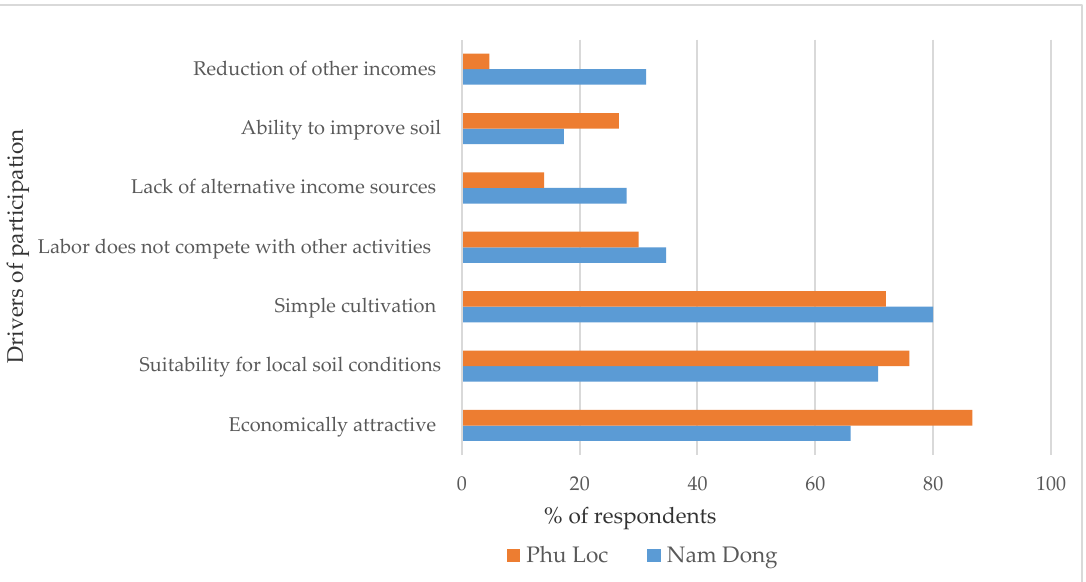
Figure 3. Producers’ reasons to engage in Acacia hybrid plantation and trade in Nam Dong and Phu Loc districts. Source: Field research (2018, 2019). Table 5. Producers’ levels of involvement in the Acacia hybrid timber business in Nam Dong and Phu Loc districts.